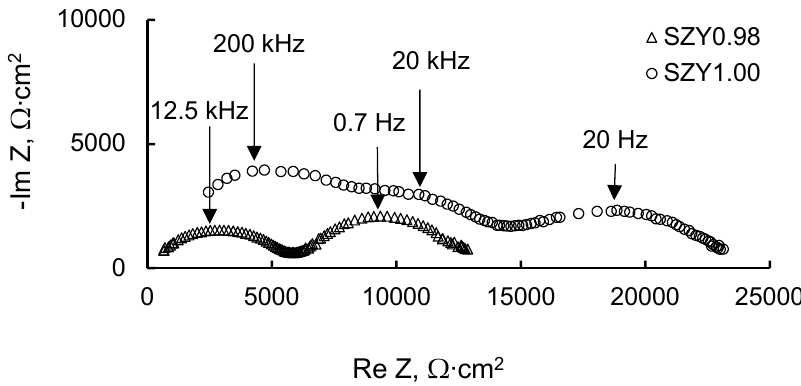
Figure 4. Impedance spectra of SZY0.98 and SZY1.00 samples at 550 °C in air (pH 2 O = 40 Pa).